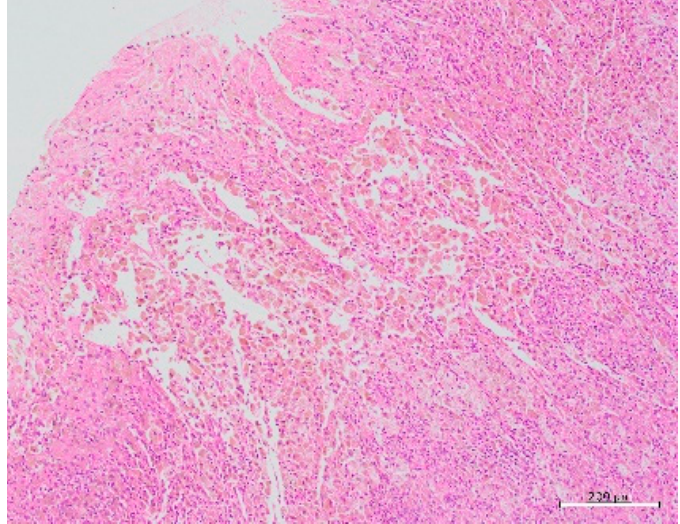
Figure 5. Histopathological picture showing glandular tissue with round nuclei and interstitial tissue scattered in islands within the tissue.